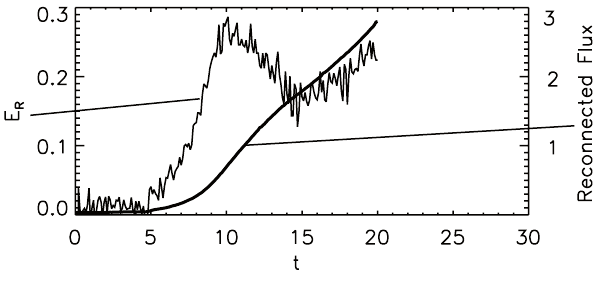
Fig. 7. PIC simulation: reconnected magnetic flux and reconnection electric field E R = E y